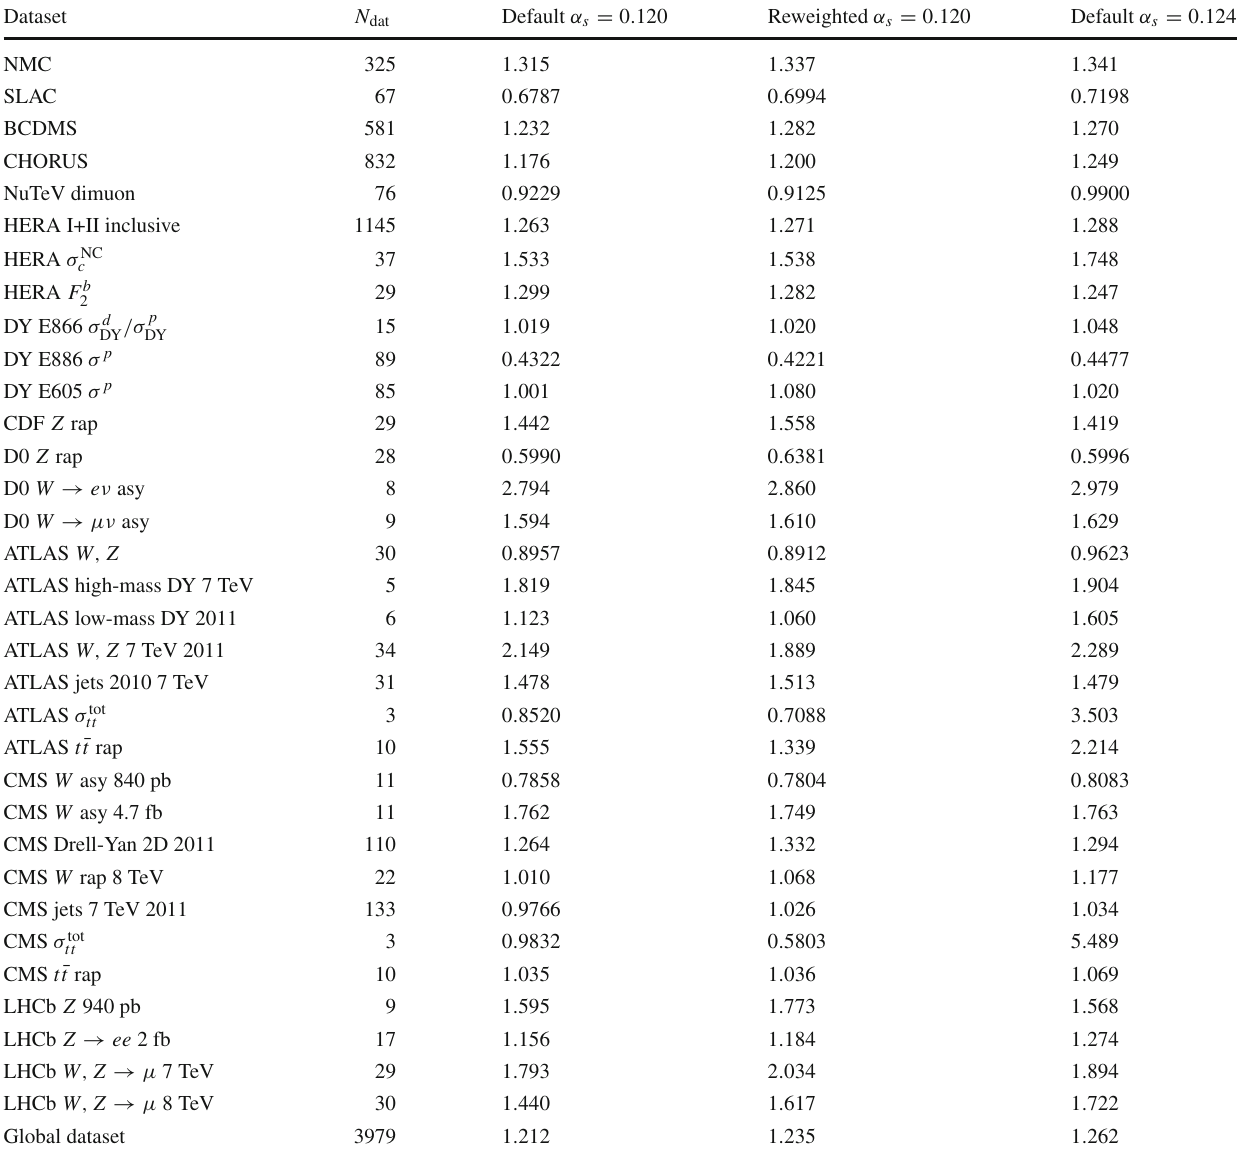
Table 1 The values of χ 2 / N dat for the experiments included in the best global fit with α s = 0 . 120, compared to results obtained when α = 0 . 124, or when the Z p s T data are given a large weight and